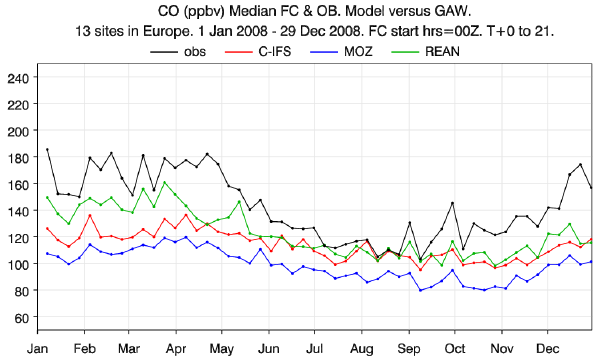
Figure 10. Time series of the median of weekly CO surface volume mixing ratios (ppb) in Europe (13 GAW sites) and model results of C-IFS, MOZ and